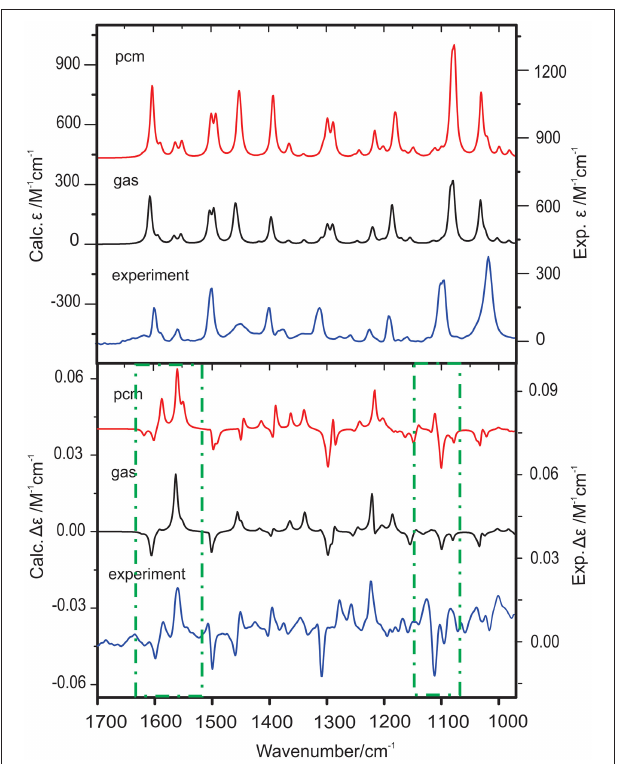
FIGURE 2 | Comparison of the simulated IR and VCD spectra in the gas phase and with PCM for CDCl 3 with the corresponding experimental spectra of Pd(TOLBINAP)Cl 2 in CDCl 3 . The regions showing noticeable different VCD patterns in the gas phase and in solution are highlighted with dashed-dotted squares. Reproduced with permission from Dezhahang et al. (2012) . Copyright 2012, The Royal Society of Chemistry.